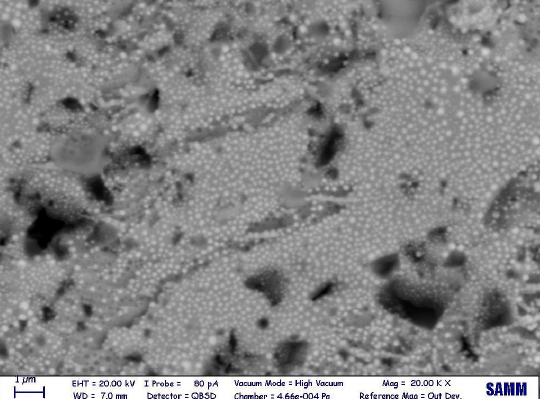
Figure 11. Spherical lead particles on the glass fit fracture surface after the die shear test.